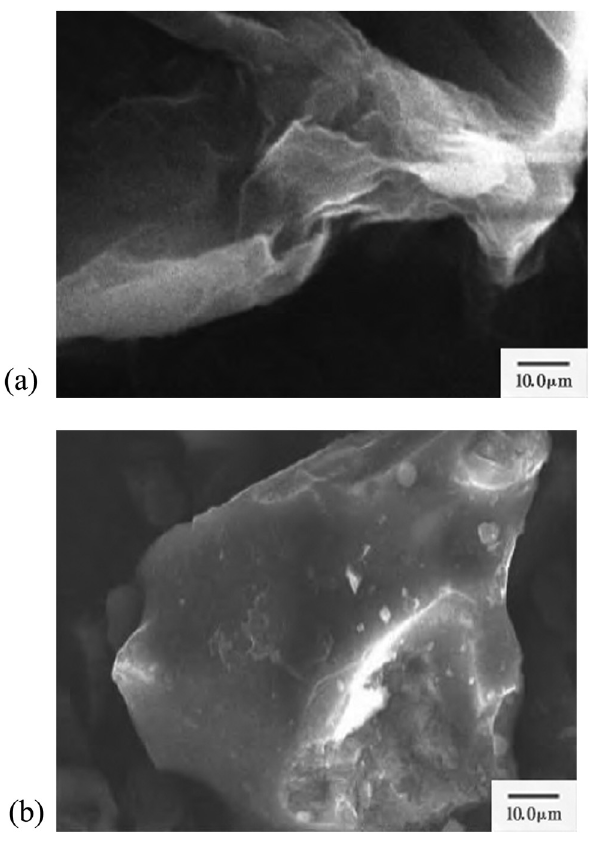
Figure 1: Scanning electron micrographs of ( a ) GO and ( b )